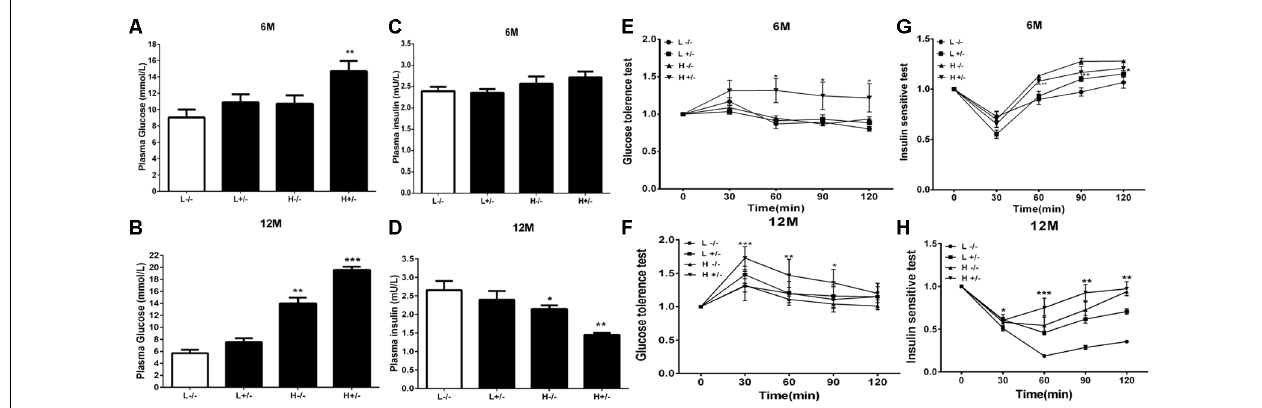
FIGURE 1 | Blood biochemistry parameters of human islet amyloid polypeptide (hIAPP − / − ) or hIAPP − / + mice fed with a high/low-fat diet for 6 or 12 months. (A) Plasma glucose content at 6 months after treatment. (B) Plasma glucose content at 12 months after treatment. (C) Plasma insulin content at 6 months after treatment. (D) Plasma insulin content at 12 months after treatment. (E) Results of the glucose tolerance test (GTT) at 6 months after treatment. (F) Results of the GTT at 12 months after treatment. (G) Results of the insulin sensitivity test at 6 months after treatment. (H) Results of the insulin sensitivity test at 12 months after treatment. L − / − denotes hIAPP − / − mice on a low-fat diet; L + / − denotes hIAPP + / − mice on a low-fat diet; H − / − denotes hIAPP − / − mice on a high-fat diet; H + / − denotes hIAPP + / − mice on a high-fat diet. n = 12, ∗ p < 0.05, ∗∗ p < 0.01, ∗∗∗ p < 0.001 compared with the L − / − group.